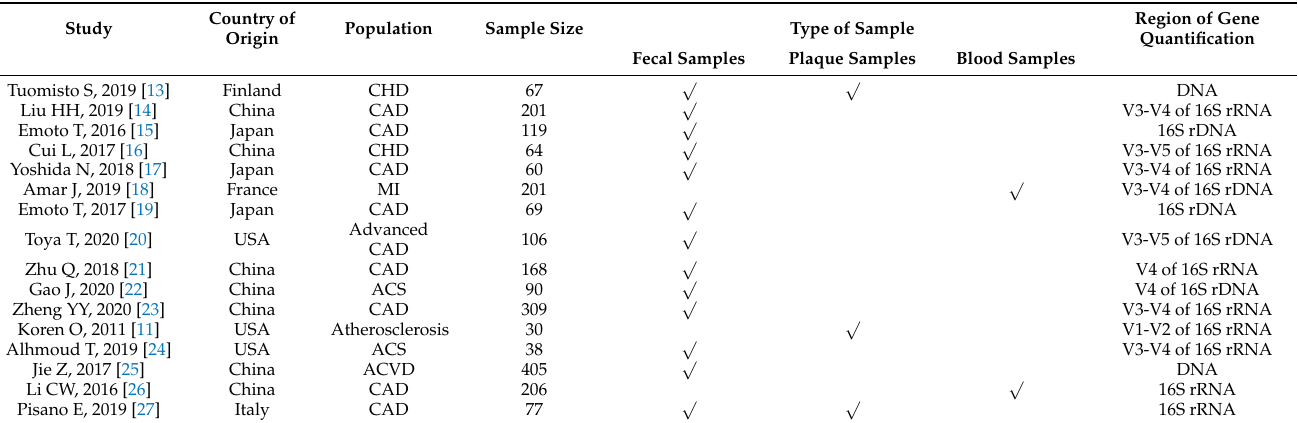
Table 1. Characteristics of included